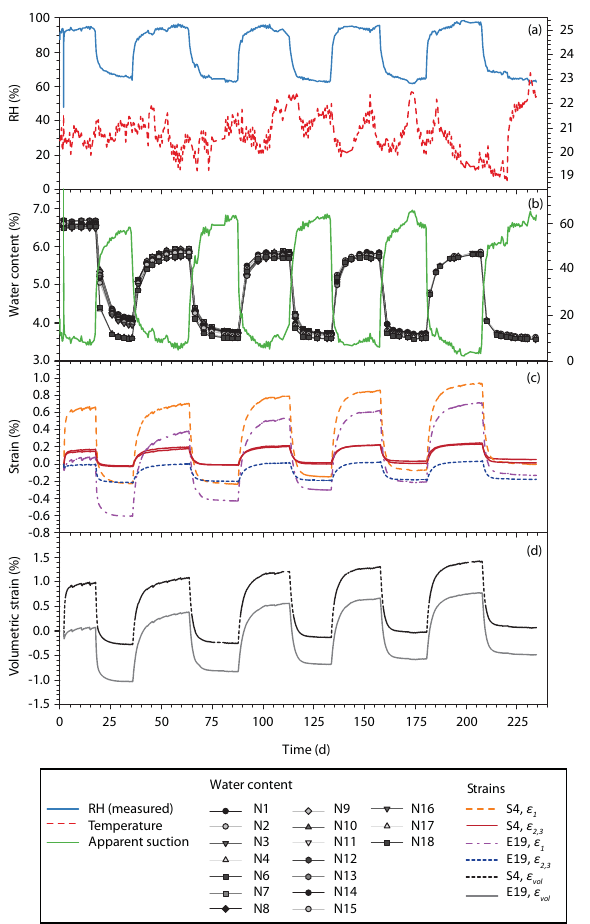
Figure 5. Results of the stepwise cyclic RH experiment for the N specimens, including (a) the changes in relative humidity (RH) and temperature, (b) the water content and apparent suction calculated from the measured RH, (c) the principal strains normal to bedding ( ε 1 ) and parallel to bedding ( ε 2 and ε 3 ) of specimens S4 and E19, and (d) the volumetric strains of specimens S4 and E19.